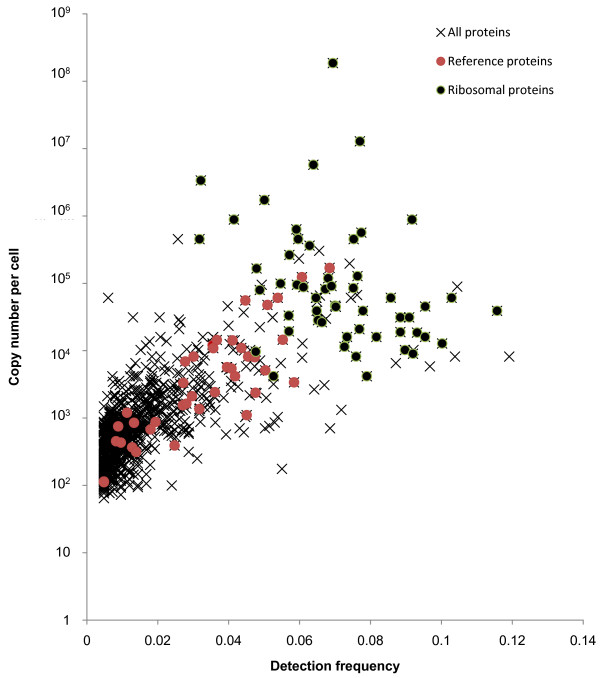
Observed concentration and protein detection frequencies. Correlation between the observed protein copy numbers (based on emPAI) and the detection frequency of the identified proteins. Detection frequency is defined as the average ratio of detection of the observed parent ions of a given protein in all performed LCMS experiments. Red dots indicate reference proteins (introduced in Figure 2), black dots indicate ribosomal proteins.